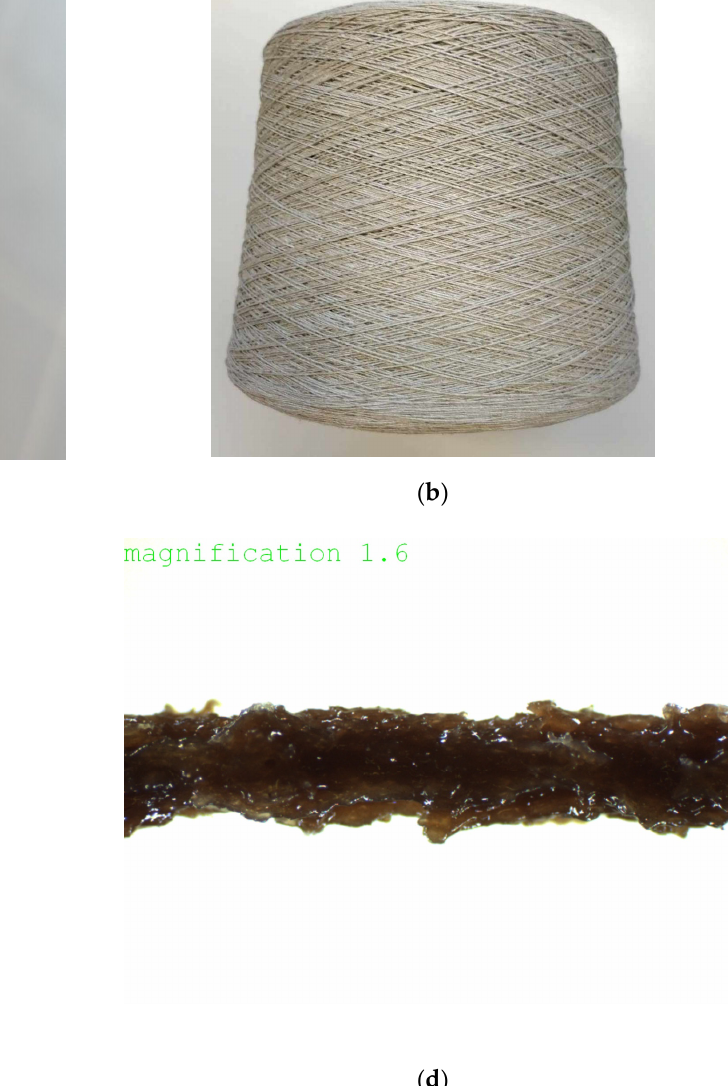
Figure 2. ( a ) Example of breakage in flax yarn; ( b ) bobbin of flax yarn (FL) without coating; ( c ) bobbin of flax yarn with lignin (FL-LI coated yarn); ( d ) close-up view of FL-LI coated yarn (the magnification is 1.6). Table 2. Parameters of extruder for production of FL-LI coated yarn.